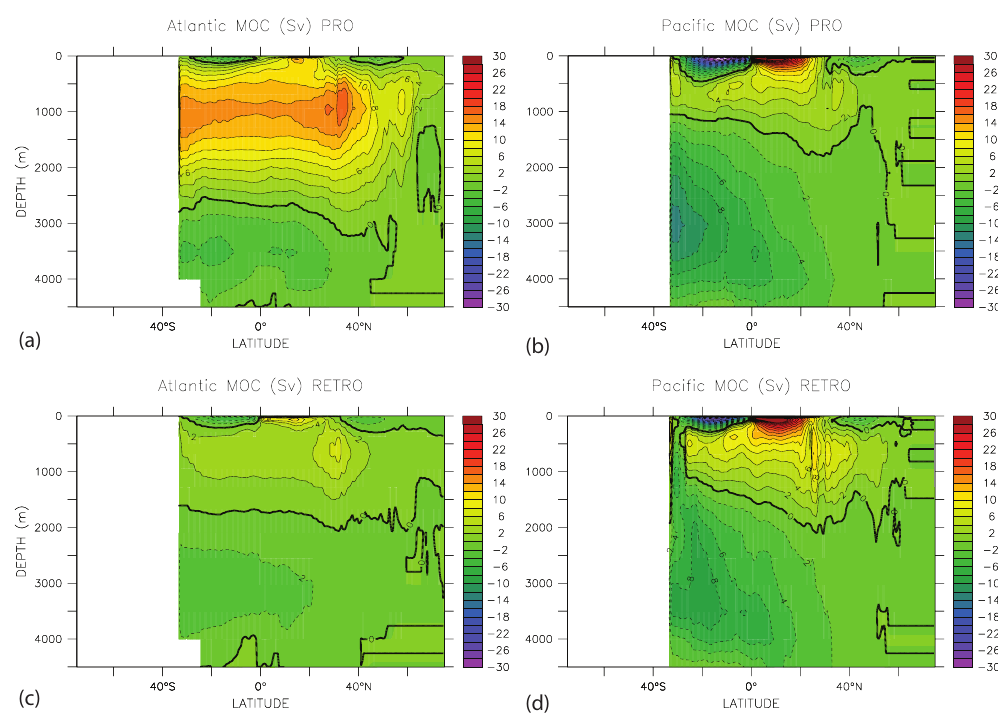
Fig. 4. Meridional overturning streamfunctions (in Sv) in the Atlantic (a) and the Pacific (b) in PRO and in the Atlantic (c) and the Pacific (d) in RETRO. In PRO, we see a Conveyor type solution, with a strong overturning cell in the Atlantic and a minimal overturning cell in the Pacific. In RETRO, the Atlantic MOC is much weaker, and in the Pacific the MOC is stronger, although sinking motion seems to take place at midlatitudes and there is no export to the Southern Ocean. Shown are the means of the years 400–500 of the CCSM3 simulation.